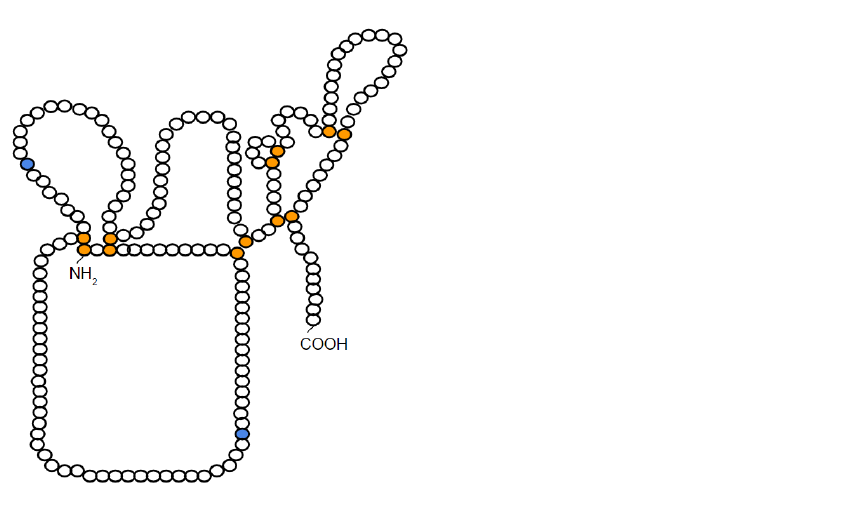
Figure 1. Schematic representation of the probable structure of TIMP-1. In orange, the cysteine residues that form the 6 disulfide bridges are depicted. In blue, the N -glycosylation sites present in TIMP-1 are represented. Figure modified from Caterina et al. [19].